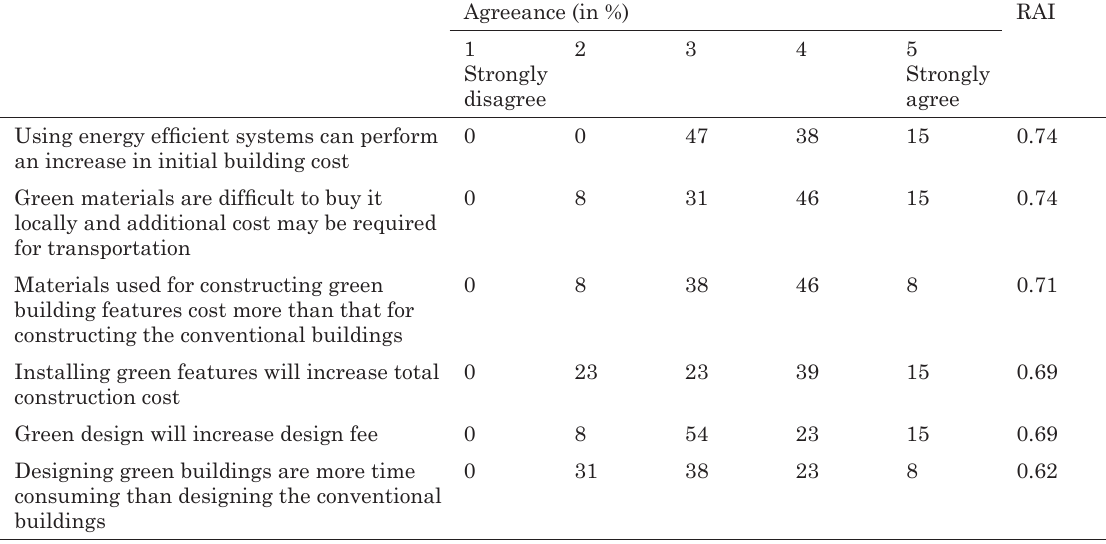
table 1. summary of survey results on economic